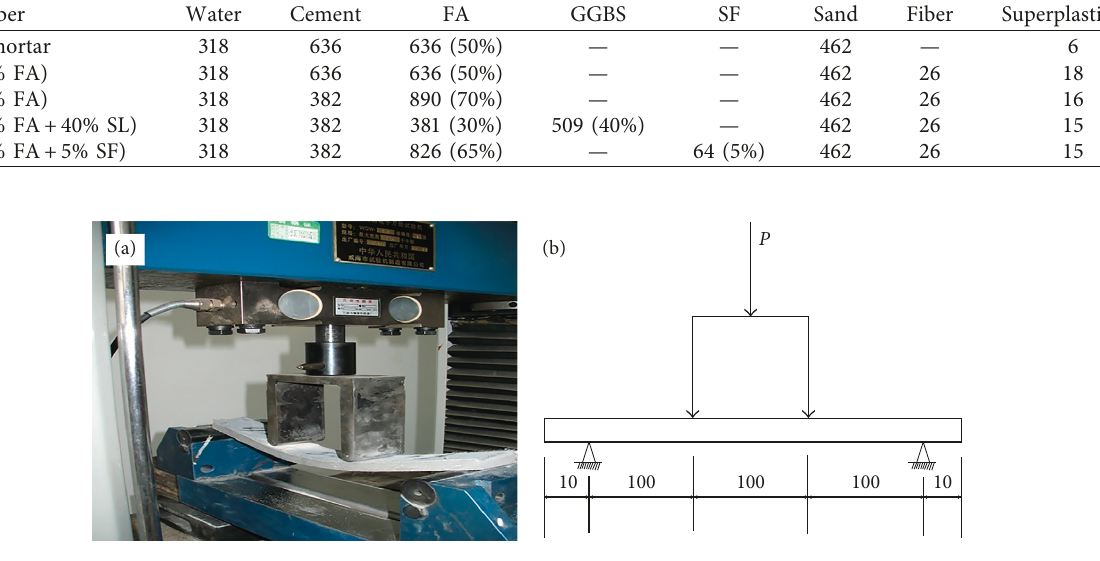
Figure 1: (a) Four-point bending test setup for ECC. (b) Loading device